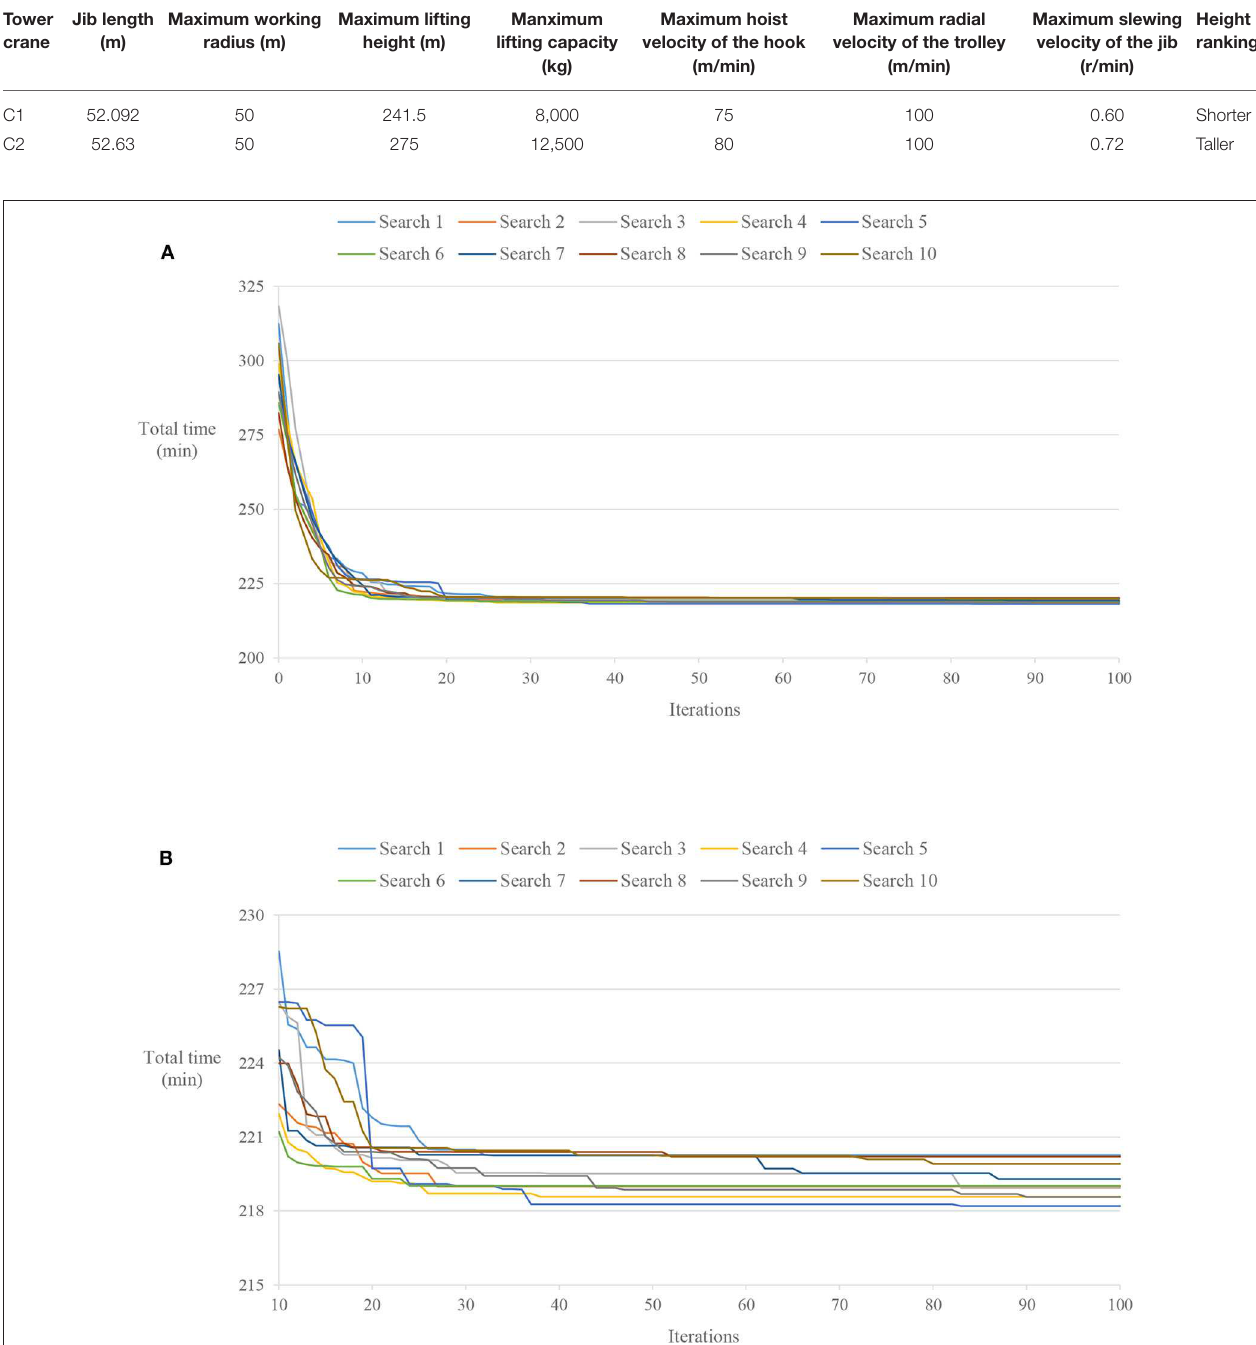
TABLE 5 | Specifications of the tower cranes.